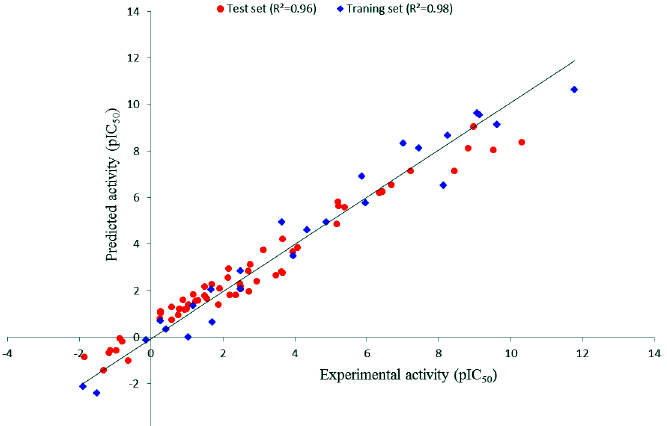
Fig 4. Correlation plot between Hypo1 predicted Btk inhibitory activities and experimental activities of 60 test set compounds and 25 training set